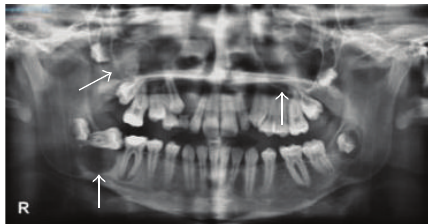
Figure 1: Orthopantomography. Odontogenic cysts (arrows).